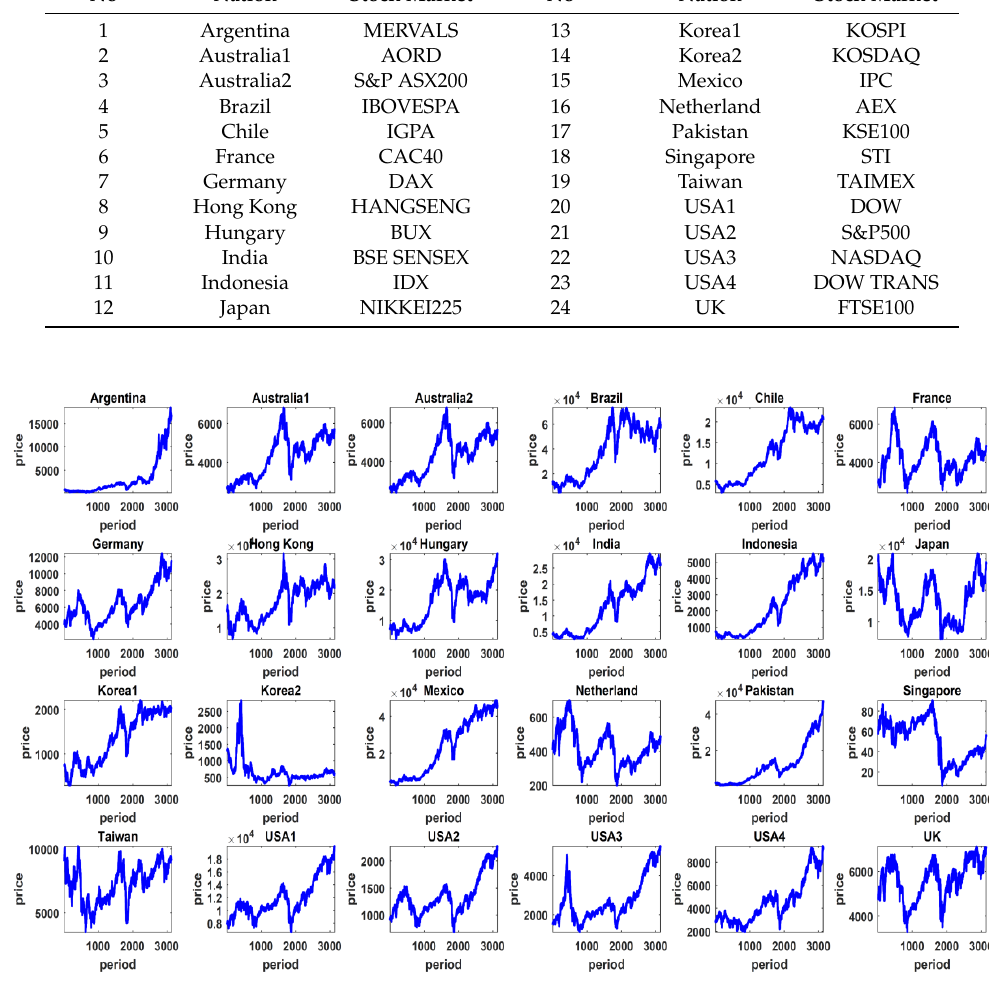
Figure 1. Time series of stock 24 price indices of all surveyed stock